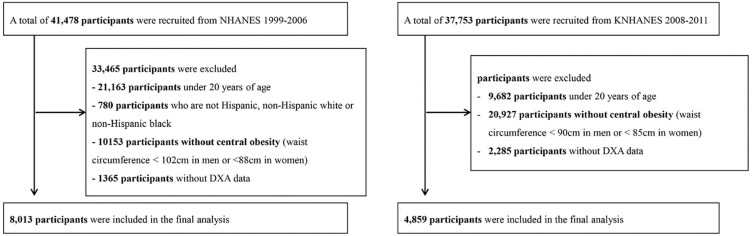
Flow chart of the final sample selection.NHANES, National Health and Nutrition Examination Survey.